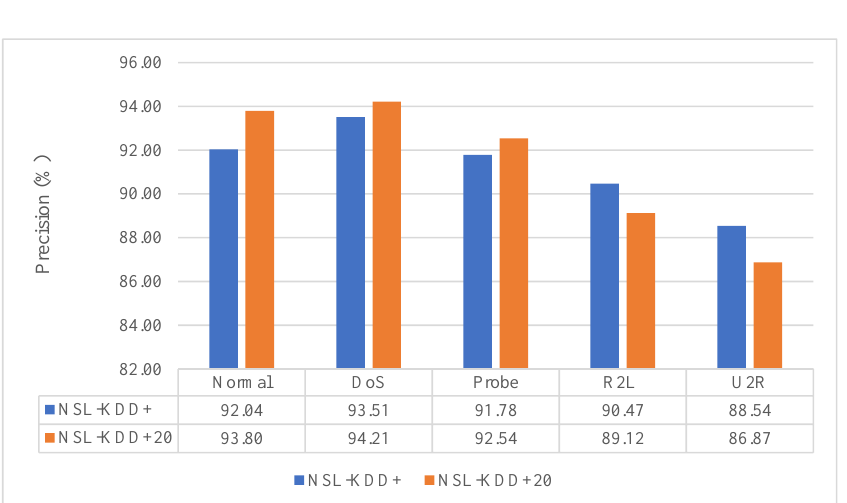
Figure 3. Precision rate of different classes on NSL-KDD+ and NSL-KDD+20 datasets.